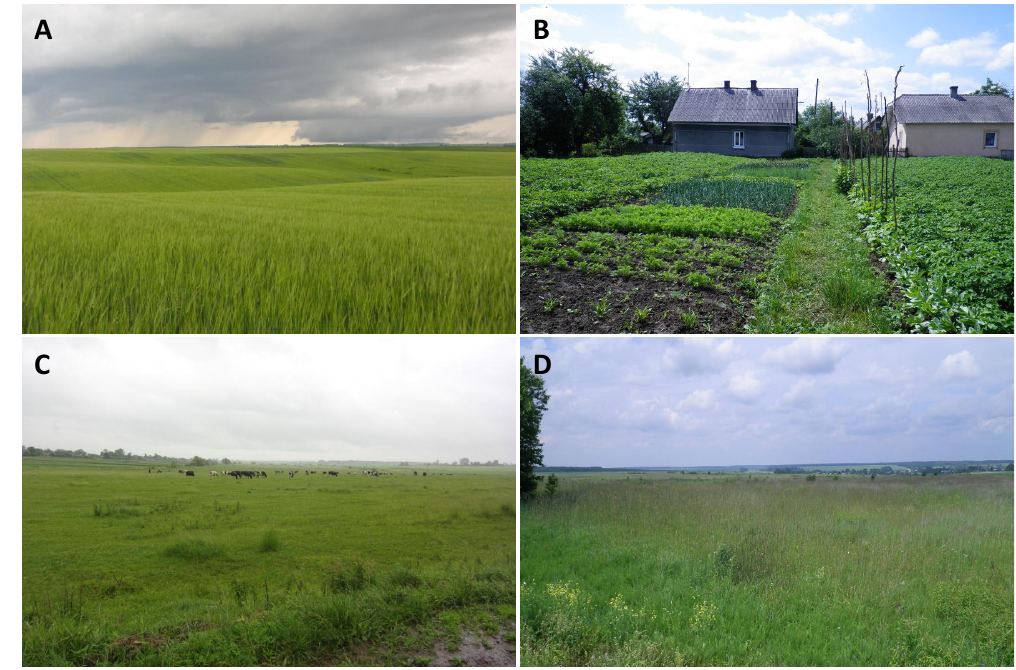
Figure 2. Photos of the agricultural category taken during our field campaign. ( A ) Large-scale cropland ( B ) Small-scale cropland ( C ) Pasture ( D ) Fallow/potential abandoned, high grass with some